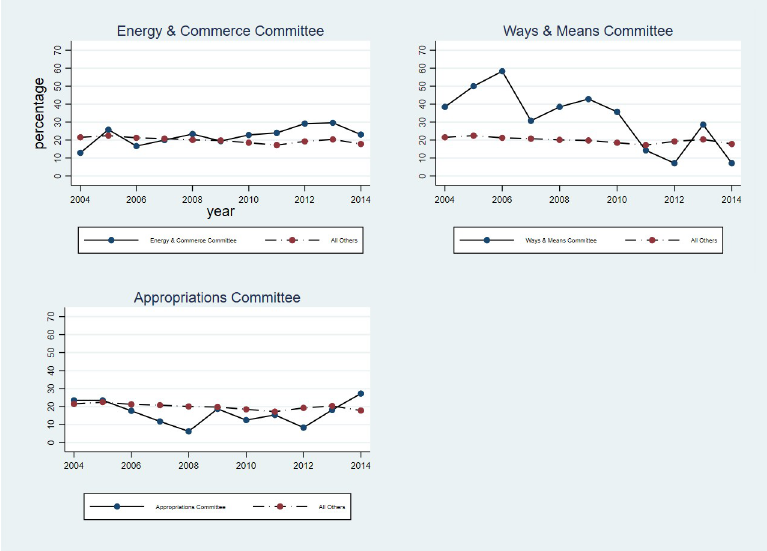
Fig 4. Share of members holding health care-related assets: House committees. � All committee samples include only those on health-related subcommittees.